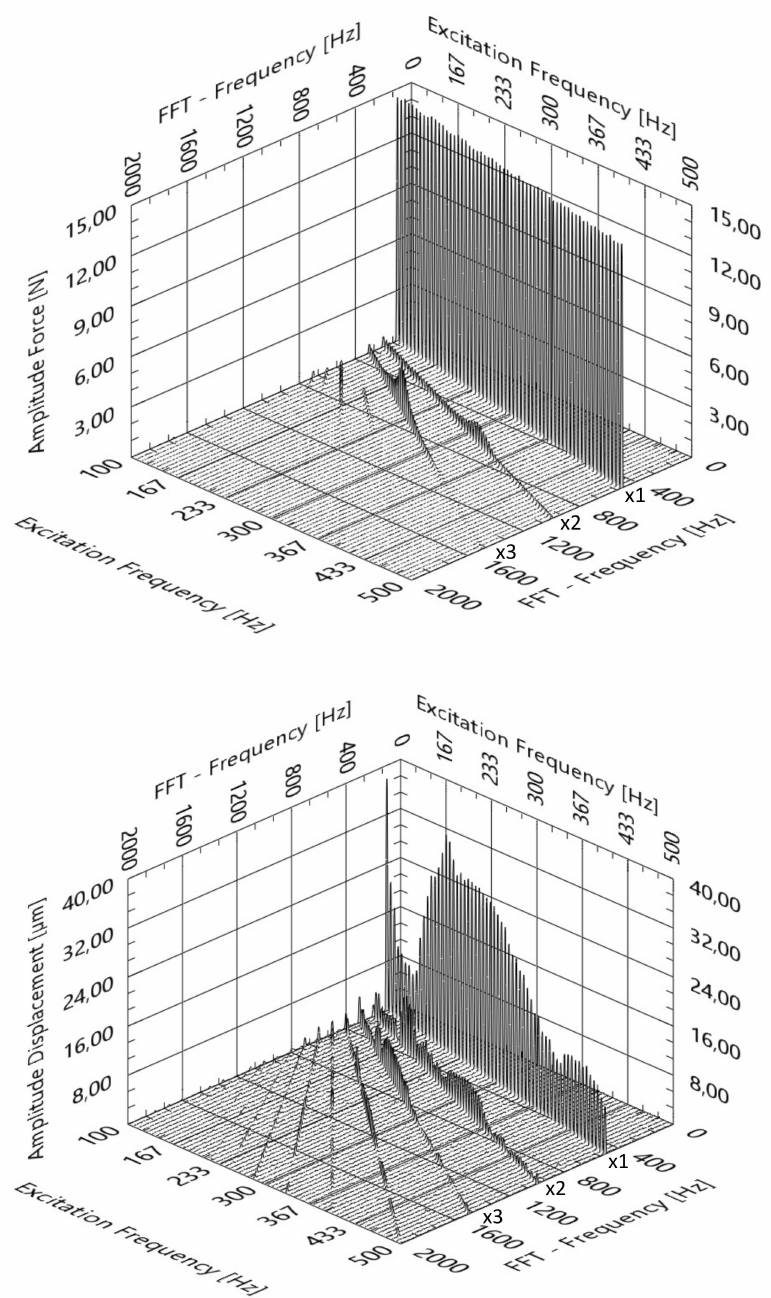
Figure A3. Waterfall plot of force and displacement sensor data in x-direction (11.1 N static load, 15 N force